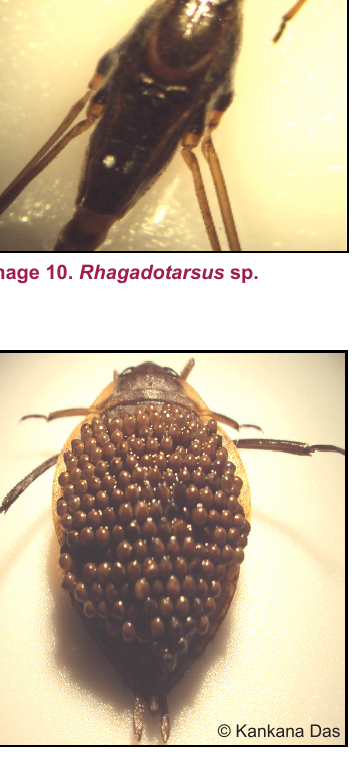
Image 13. Diplonychus rusticus (with eggs)